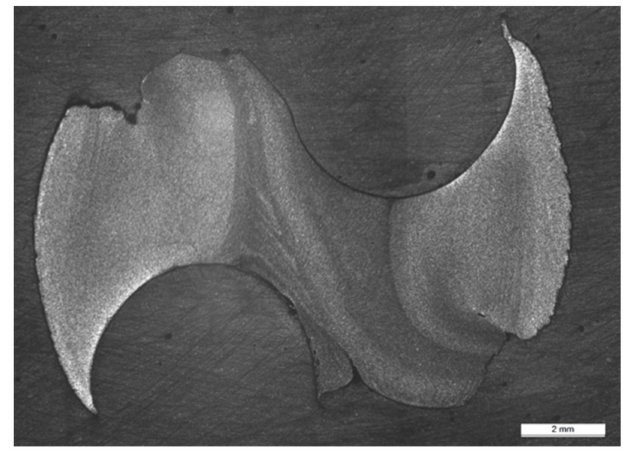
Figure 11. Material between the welding pins.